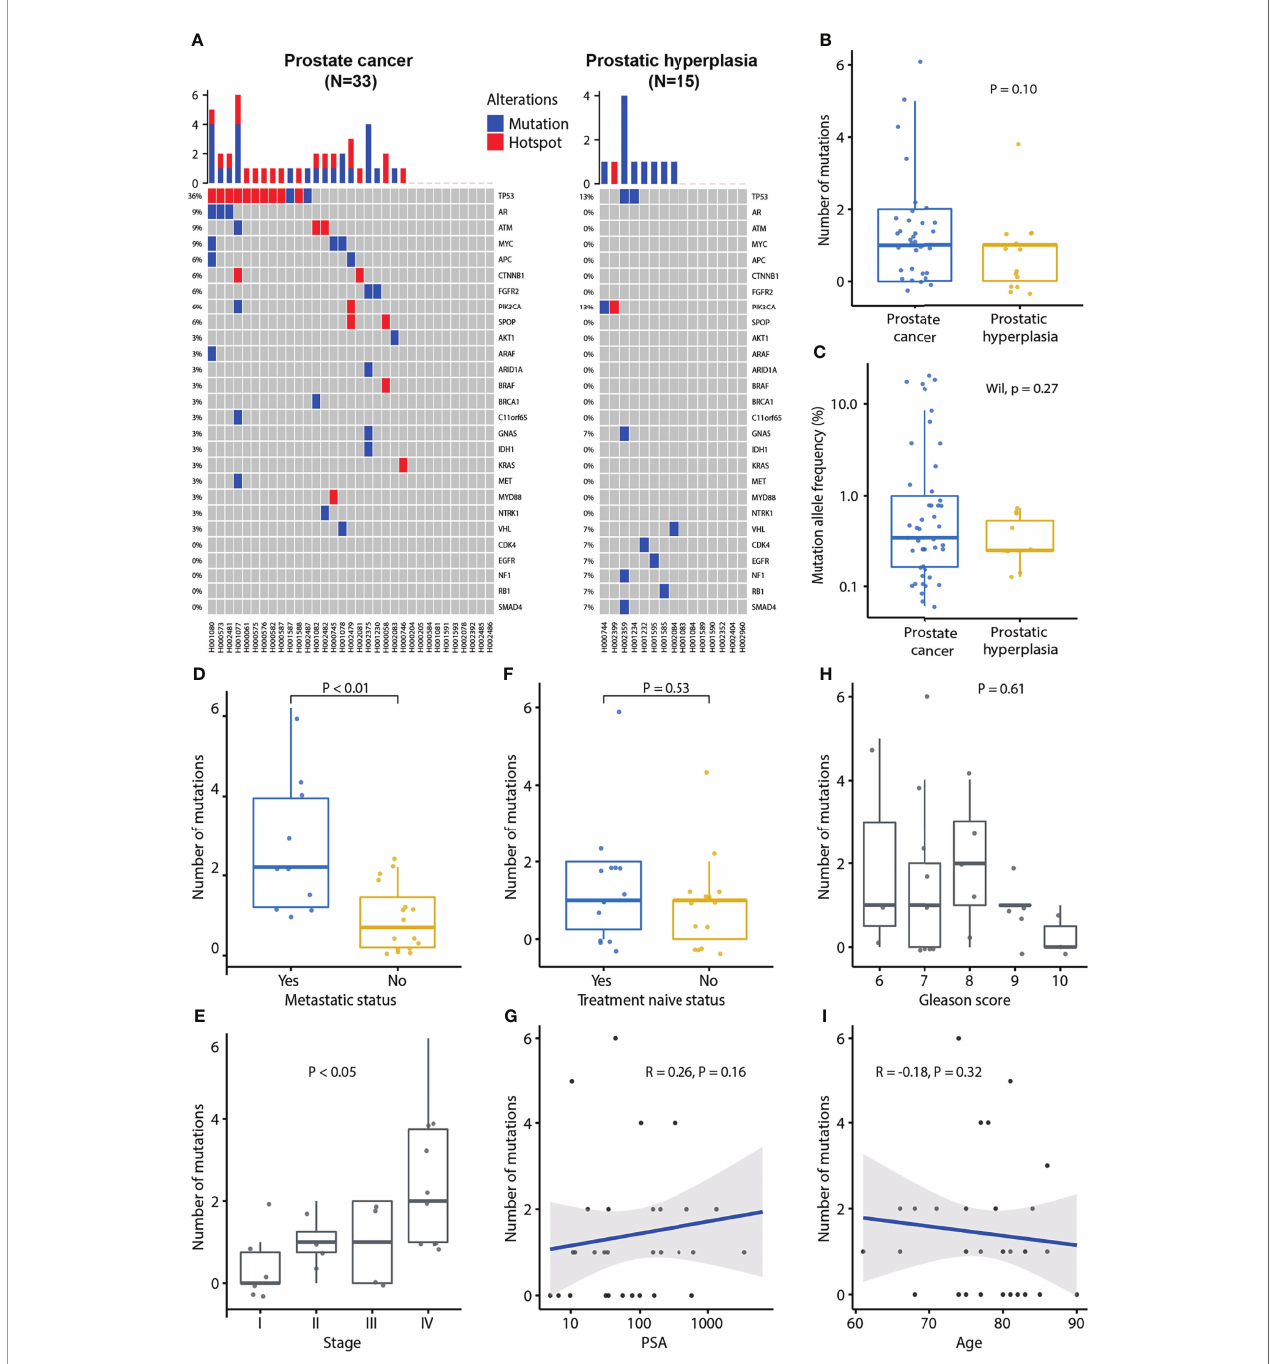
FIGURE 1 | Plasma cfDNA mutation pro fi les and association of the number of mutations detected in plasma cfDNA and clinical characteristics of prostate cancer. (A) cfDNA mutation pro fi le of prostate cancer and prostatic hyperplasia. Blue color indicates mutation and red color indicates hotspot mutation which is de fi ned as a mutation with occurrence greater than 20 in the COSMIC database. (B) The number of mutations in prostate cancer and prostatic hyperplasia. (C) Mutation allele frequencies in prostate cancer and hyperplasia. (D) Association of the number of mutation and metastatic status. p-value was calculated by the Mann-Whitney U test. (E) Association of the number of mutations and tumor stage. P-value was calculated by the Kruskal-Wallis test. (F) Association of the number of mutations and treatment naïve status. P-value was calculated by the Mann-Whitney U test. (G) Association of the number of mutations and PSA. Spearman ’ s rank correlation coef fi cient and the corresponding P-value are shown. (H) Association of the number of mutations and Gleason score. P-value was calculated by the Kruskal-Wallis test. (I) Association of the number of mutations and age. Spearman ’ s rank correlation coef fi cient and the corresponding p-value are shown. Each dot indicates one